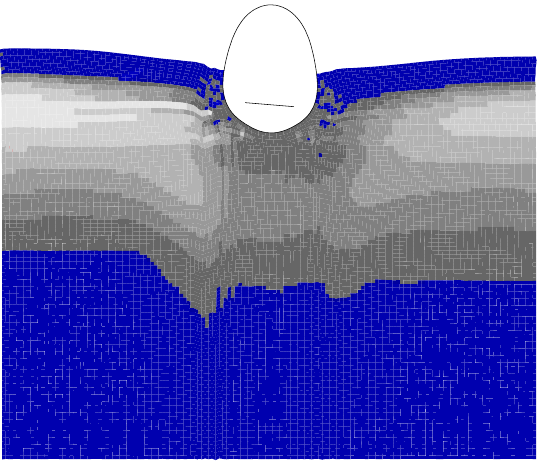
Fig. 5. Pressure/cavitation contours and deformations for 60 ms. Fig. 6. Pressure/cavitation contours and deformations for 190 ms, showing cavitation